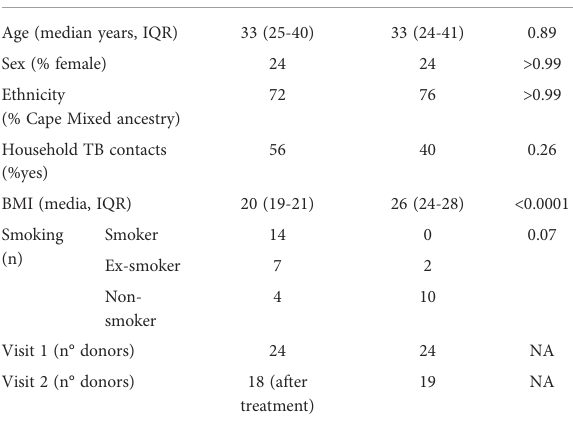
TABLE 1 Tuberculosis cohort